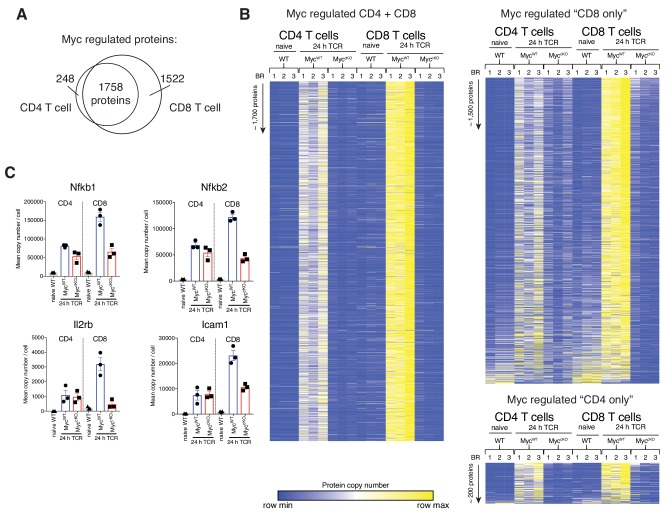
Myc-deficiency has a larger quantitative effect in CD8+ T cells.Naïve WT and 24 hr TCR activated MycWT and MyccKO proteomic data was generated as described in Figure 1 and Materials and methods. (A) Venn diagram showing that there were a larger number of proteins that were classified as differentially regulated in CD8+ T cells compared to CD4+ T cells, where differentially regulated is defined as proteins that were more than 2-fold regulated and p<0.05 between MycWT vs MyccKO TCR activated conditions. (B) Heat maps of proteins that were Myc-regulated in CD4+ T cells only, both CD4+ and CD8+ T cells or CD8+ T cells only show similar qualitative effects of Myc-deficiency for most proteins. Relative protein abundance is graded from low (blue) to high (yellow) per row. (C) Mean copy number per cell for examples of proteins classified as Myc-regulated in CD8+ T cells only. Protein expression was much higher in MycWT CD8 T cells compared MycWT CD4+ T cells, whereas expression levels in MyccKO CD4+ and CD8+ T cells are reduced to a similar extent thus giving a larger quantitative effect of Myc-deficiency in CD8+ T cells. Examples include important transcription factors such as Nfkb1 and Nfkb2, the integrin Icam1 and cytokine receptor components such as Il2rb. Symbols show biological replicates. Mean ± S.E.M. Fold-change calculations and statistical testing comparing naïve WT vs TCR MycWT, naïve WT vs TCR MyccKO, and TCR MycWT vs TCR MyccKO protein copy number per cell is listed in Supplementary file 1.